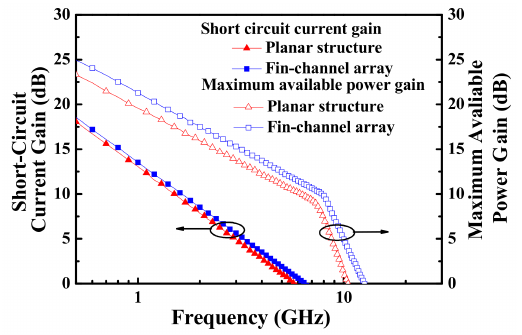
Figure 4. Short-circuit current gain and maximum available power gain as a function of frequency of double-channel